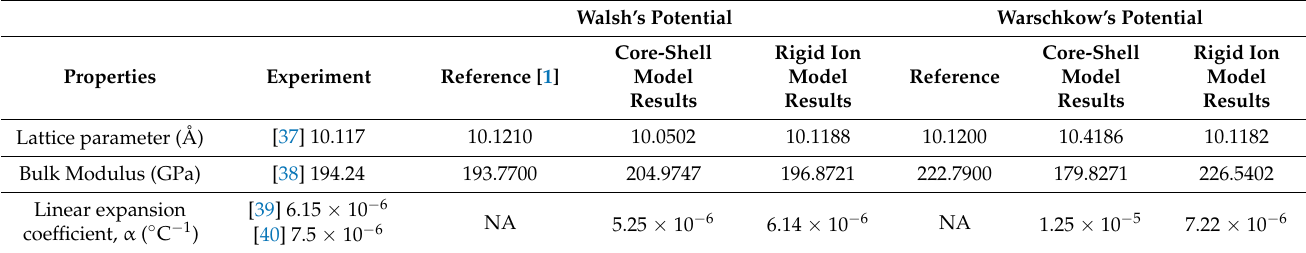
Table 2. Comparison of the different In 2 O 3 interatomic potentials and experimental